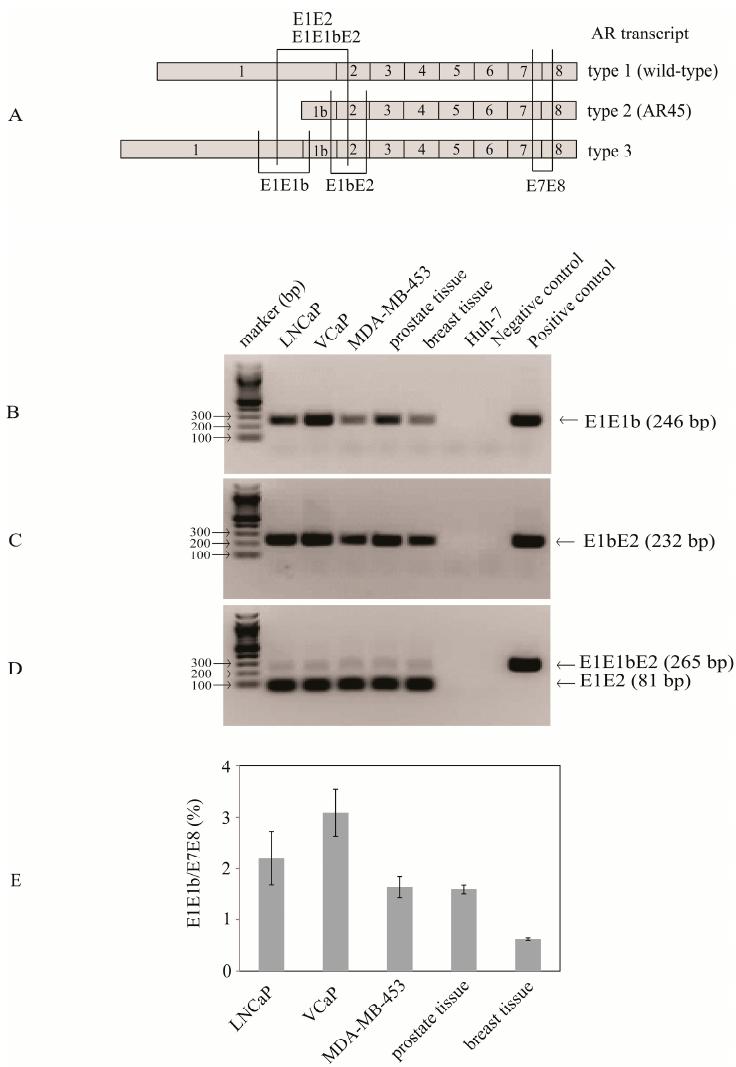
Figure 1. Expression of AR transcripts in breast and prostate cancer cell lines and normal breast and prostate cancer tissues. Primers were used to amplify the junction region of exon 1/exon 1b (E1E1b for type 3 AR only), exon 1b/exon 2 (E1bE2 for type 2 and type 3 AR), or exon 1/exon 1b/exon 2 (E1E2 for type 1 AR and E1E1bE2 for type 3 AR) using cDNA from normal breast and prostate tissues, MDA-MB-453, LNCaP, VCaP, and Huh-7 cells. Positive controls use pcDNA3/type 3a as template; negative controls use mock RT products (without RNA) as template. ( A ) Schematic showing regions of AR transcripts amplified via RT-PCR; ( B – D ) electrophoretic separation showing the expected sizes of RT-PCR products; and ( E ) quantitative RT-PCR analysis of type 3 AR (using E1E1b primers) and wild-type AR (using E7E8 primers). Expression levels of type 3 AR are shown as a percentage of wild-type AR (set to 100%). Data shown are means ± SEM of three independent experiments.